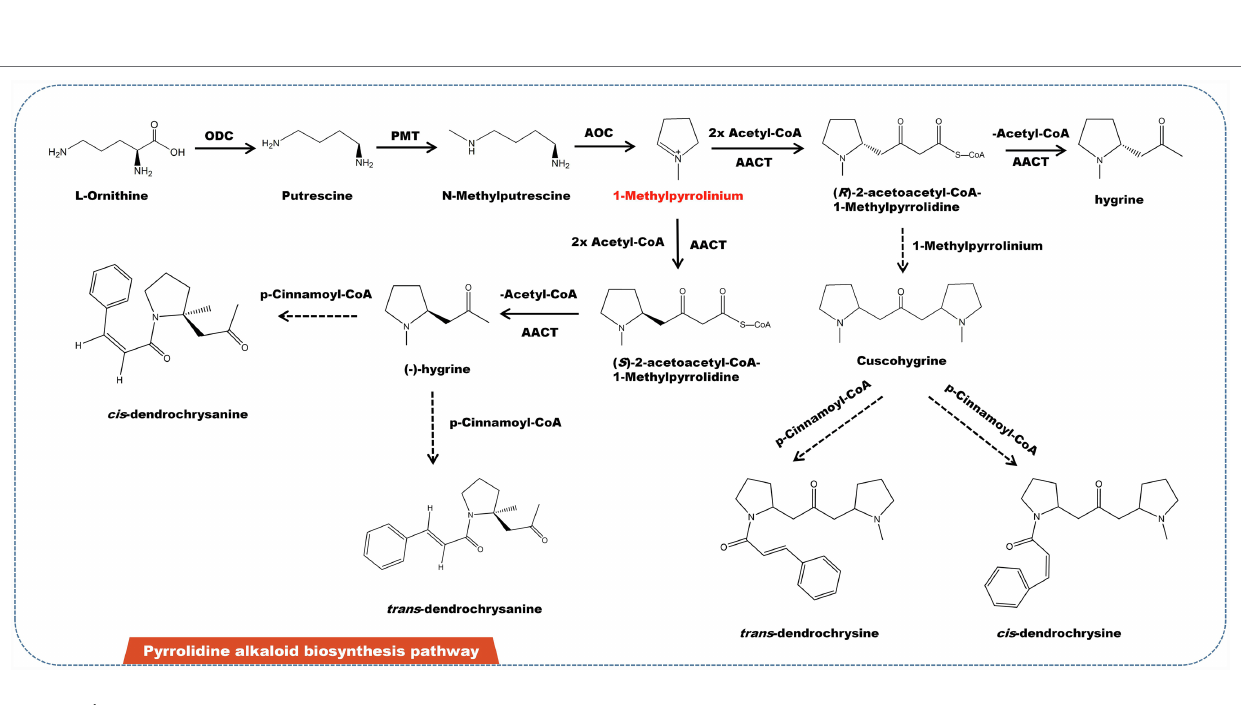
FIGURE 4 | A plausible biosynthesis pathway of pyrrolidine alkaloids. The dashed box represents the putative enzymes. The dashed arrow represents the speculated pathway. Ornithine decarboxylase (ODC), putrescine N-methyltransferase (PMT), primary amine: oxygen oxidoreductase (AOC), acetyl-CoA acetyltransferase (AACT). Under the catalysis of AOC, methylputrescine is deaminated and oxidized to produce the precursor